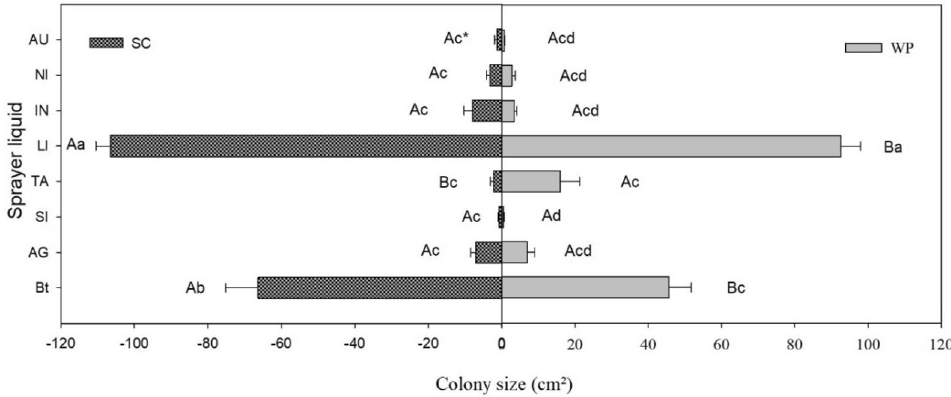
Figure 1. Mean size of colonies in Bt biopesticide and adjuvant mixtures. *Capital letters compare the effect of formulations. Lower case letters compare the effect of adding an adjuvant to sprays. SC suspension concentrate,